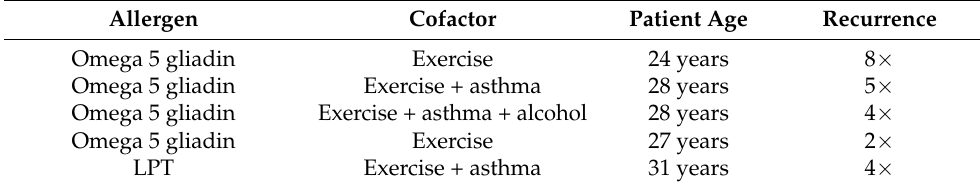
Table 4. Characteristics of patients with Food-dependent exercise-induced anaphylaxis